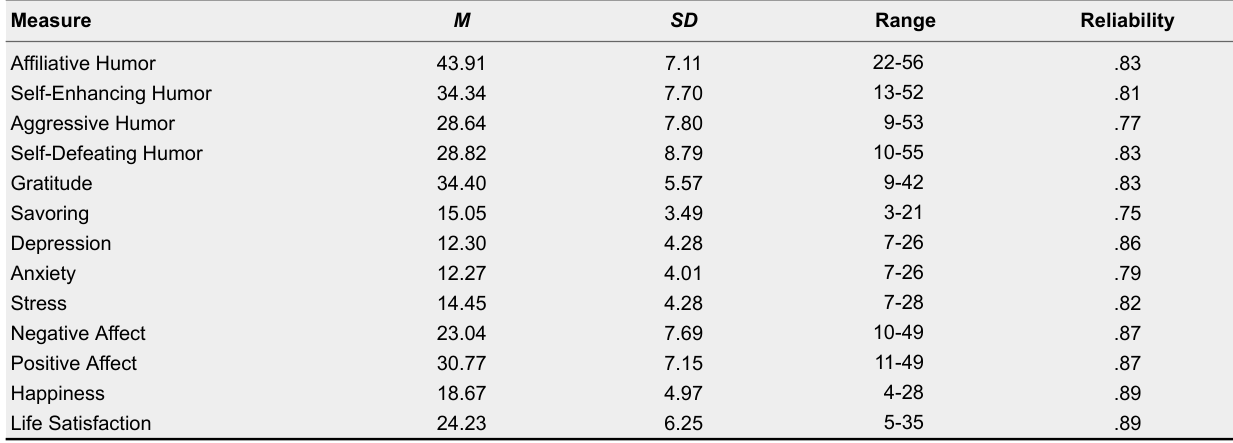
Means, Standard Deviations, Range and Reliabilities for All